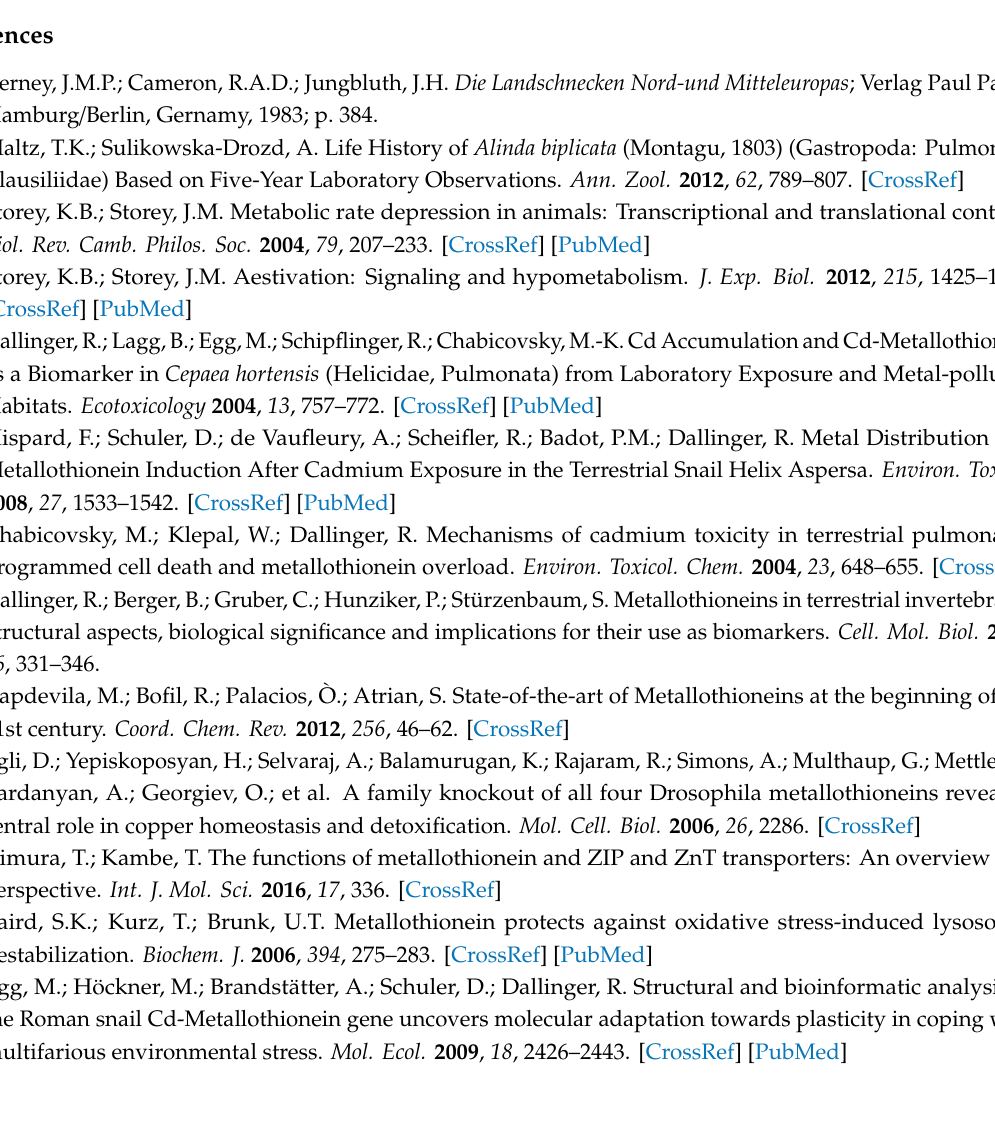
Figure S1: Documented feeding behavior of controls and snails exposed to increased concentrations of Cd, Figure S2: Alignments of partial md-MT peptide sequences with the full-length 10md-MT . Figure S3: (A) Alignmnent of all N-domains of the 9md-MT and 10md-MT of Alinda biplicata; (B) Sequence coverage of the 9md-MT and 10md-MT consensus sequences of Alinda biplicata (Ab) with Cd- and Cu-specific MTs of helicid snails Table S1: Sequence comparison o ff all single domains of the 9md-MT (9N1-9N9; 9C) and 10md-MT (10N1 – 10N9, 10C) of Alinda biplicata ; Table S2: Characterization of gene specific primers and PCR parameters used for amplification of the 9md and 10md-MT